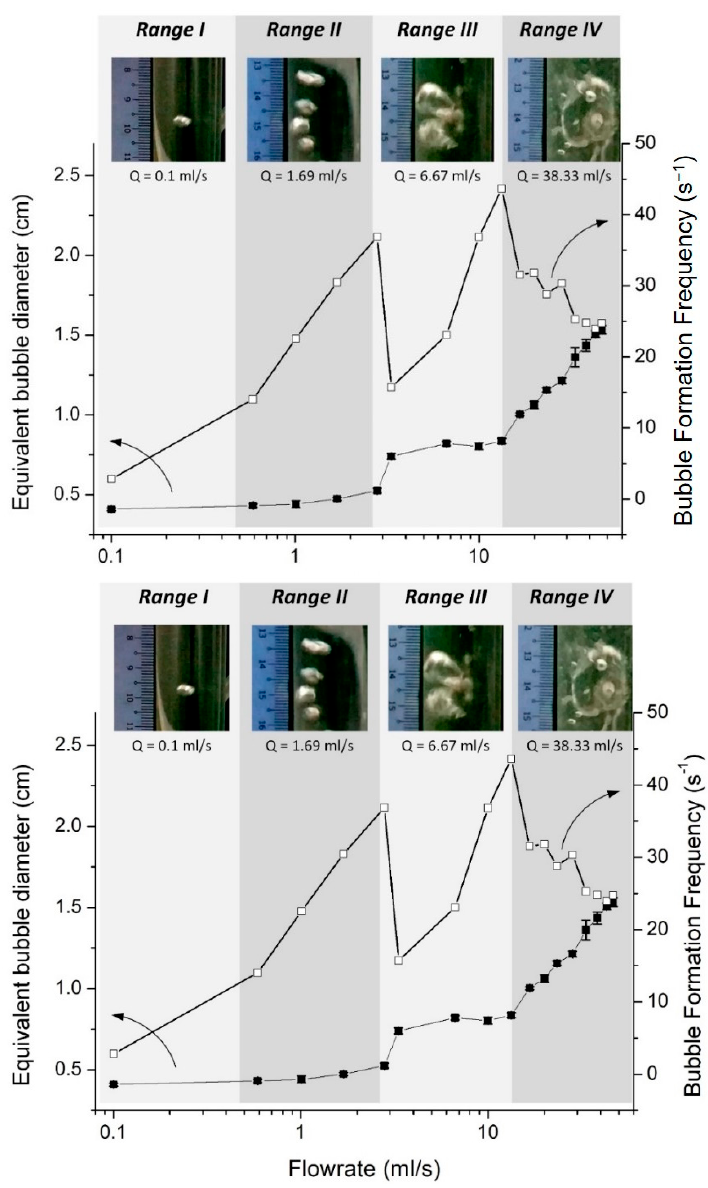
Figure 9. Schematic diagram of bubble formation at different air flow rates.